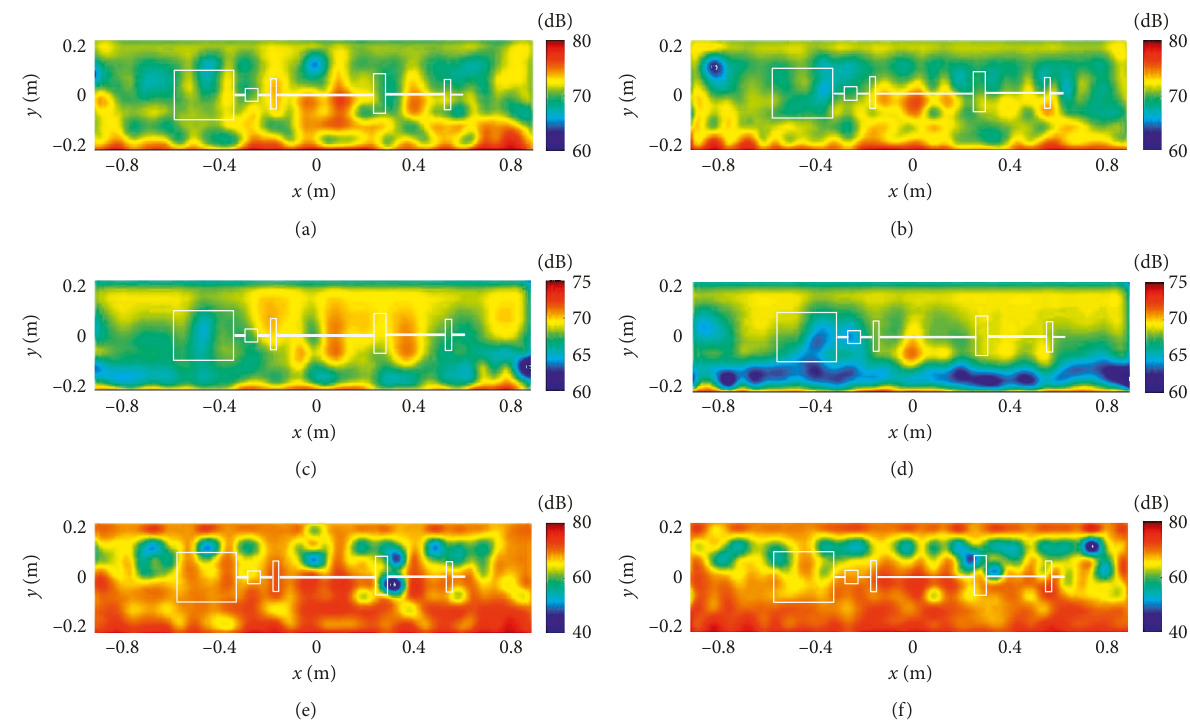
Figure 7: The 2.5D sound field model obtained under experimental conditions. (a) Normal state source image; (b) fault state source image; (c) normal state holographic sound image; (d) fault state holographic sound image; (e) normal state difference sound image; (f) fault state difference sound image.